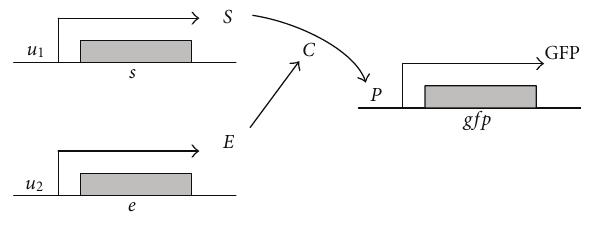
Figure 1: An example of a biological module. The substrate S is designed to bind an enzyme E essential for the reaction, which can be triggered by the input signals, say u 1 and u 2 , cooperatively. In the biologic process, the two proteins can combine together to form a complex C which then breaks down into the production P with E being released. The presence of production P alone leads to the synthesis of the output signal, the reporter protein